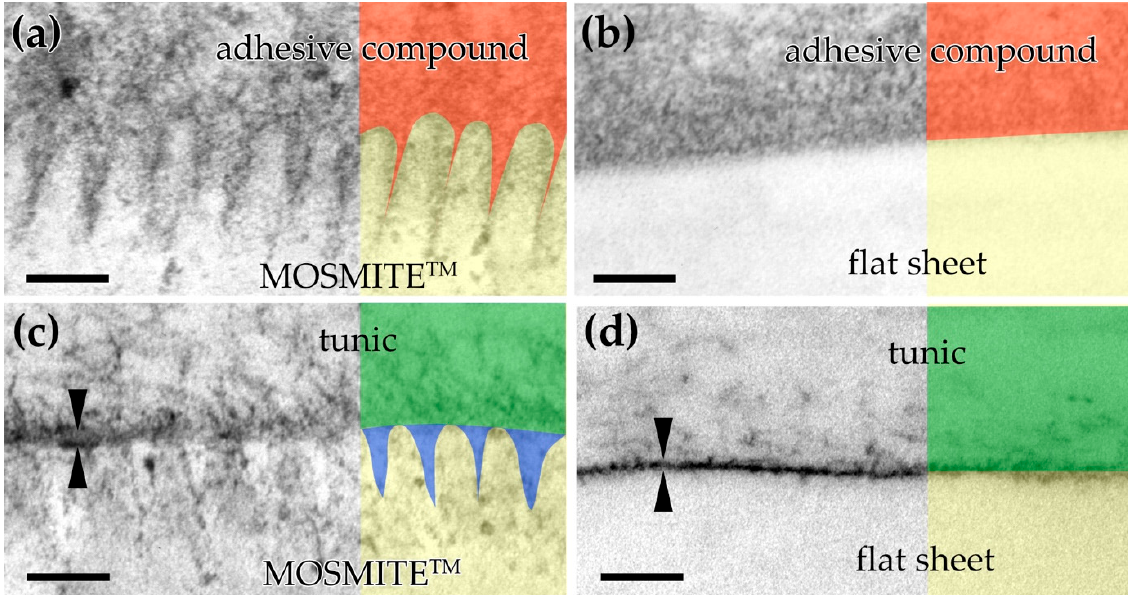
Figure 6. Electron micrographs of the adhesion point between the substrate (yellow) and adhesive compound (red) or tunic (green) in the settlement of Phallusia philippinensis . ( a ) Adhesive compound on MOSMITE TM . ( b ) Adhesive compound on flat sheet. ( c ) Tunic on MOSMITE TM . Vacant space remains between the nipple array layer (blue). ( d ) Tunic on flat sheet. Facing arrowheads indicate tunic cuticle. Scale bars 100 nm.